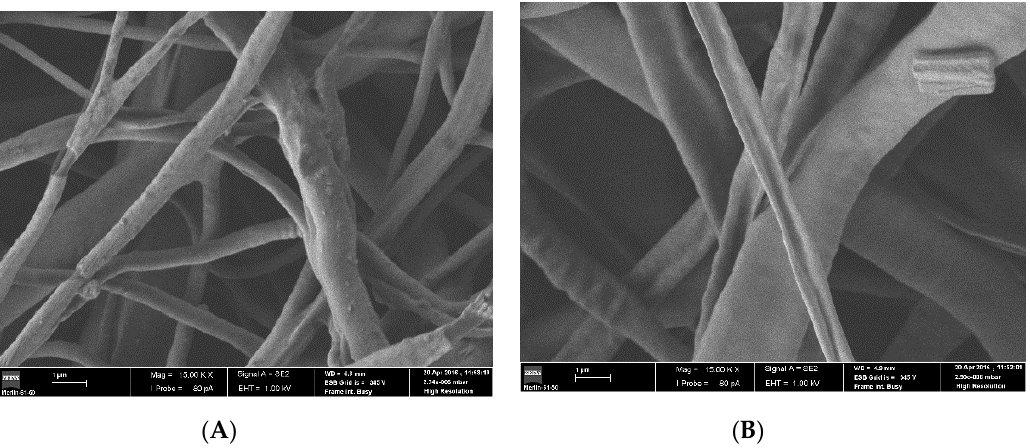
Figure 2. Images obtained by SEM. ( A ) Blending implant fibers, ( B ) EDW implant fibers.